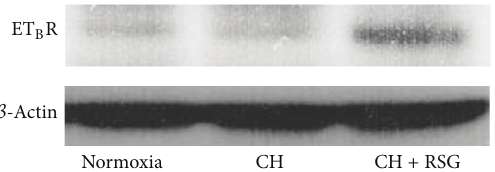
Figure 3: Rosiglitazone upregulated ET PAH. Western blotting was performed with the protein samples extracted from the pulmonary arteries of normoxia-, CH-, or RSG- treatedCH-rats.Datashownarerepresentativeofthreeindependent